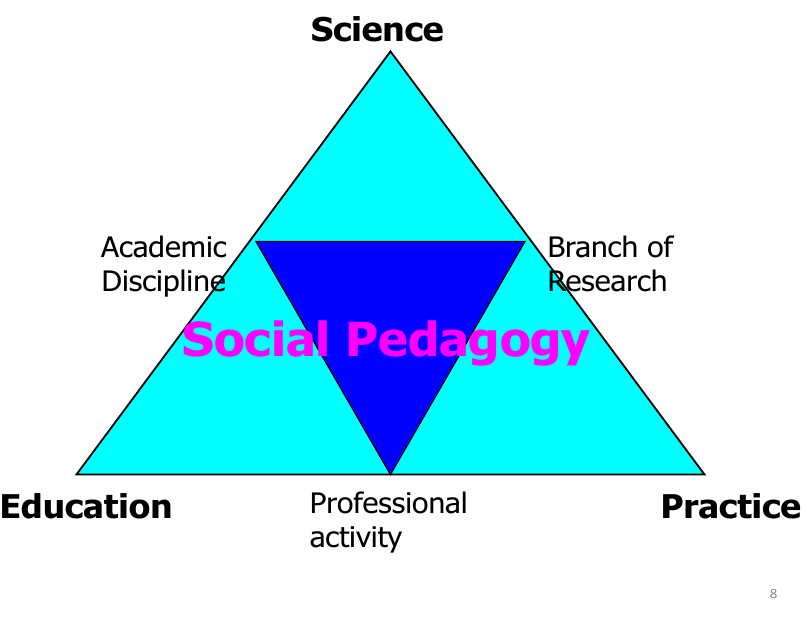
Figure 1. Social pedagogy as a functional system of science, education and practice